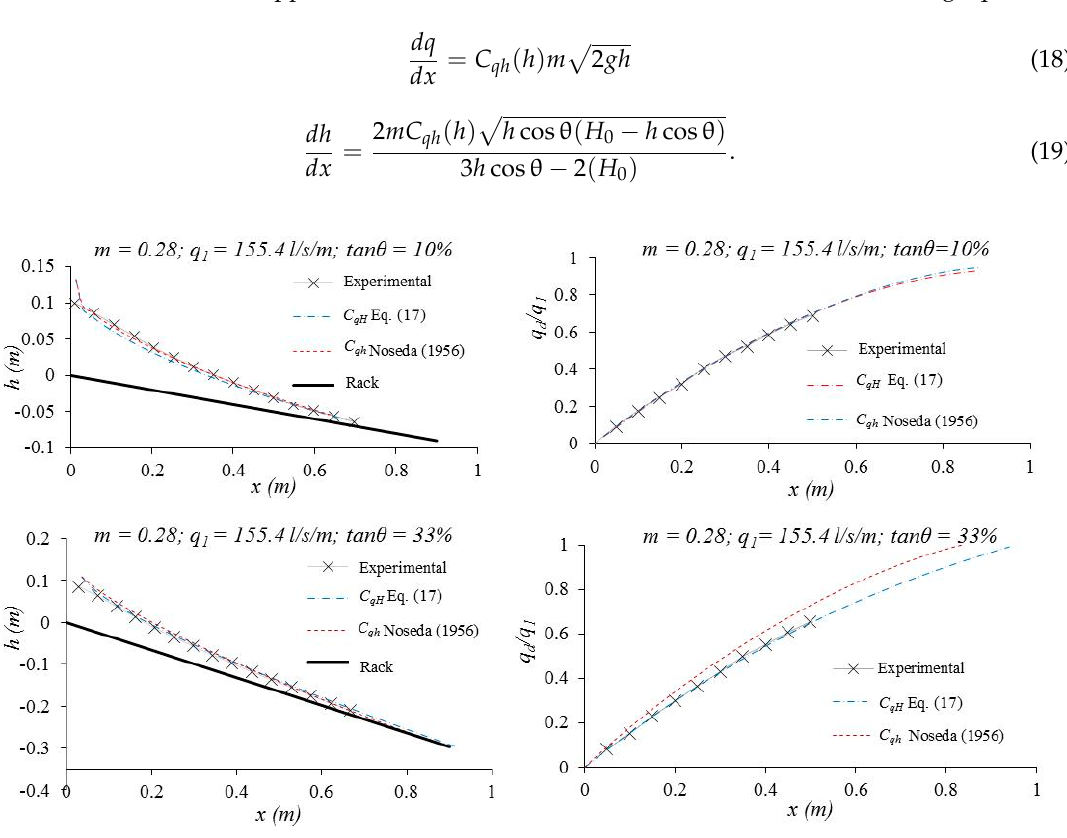
Figure 15. Flow profile and derived flow per unit length calculated and measured in the lab for slopes of 10% and 33%.